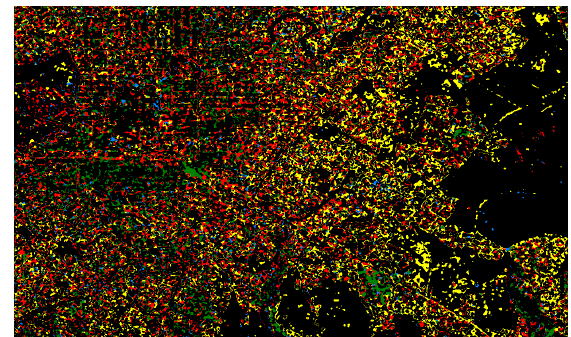
Figure 12. Zones not affected (black) vs. zones affected by the earthquake: yellow - always active, green - always not active, blue - active before and not active after, red - not active before and active after the earthquake.